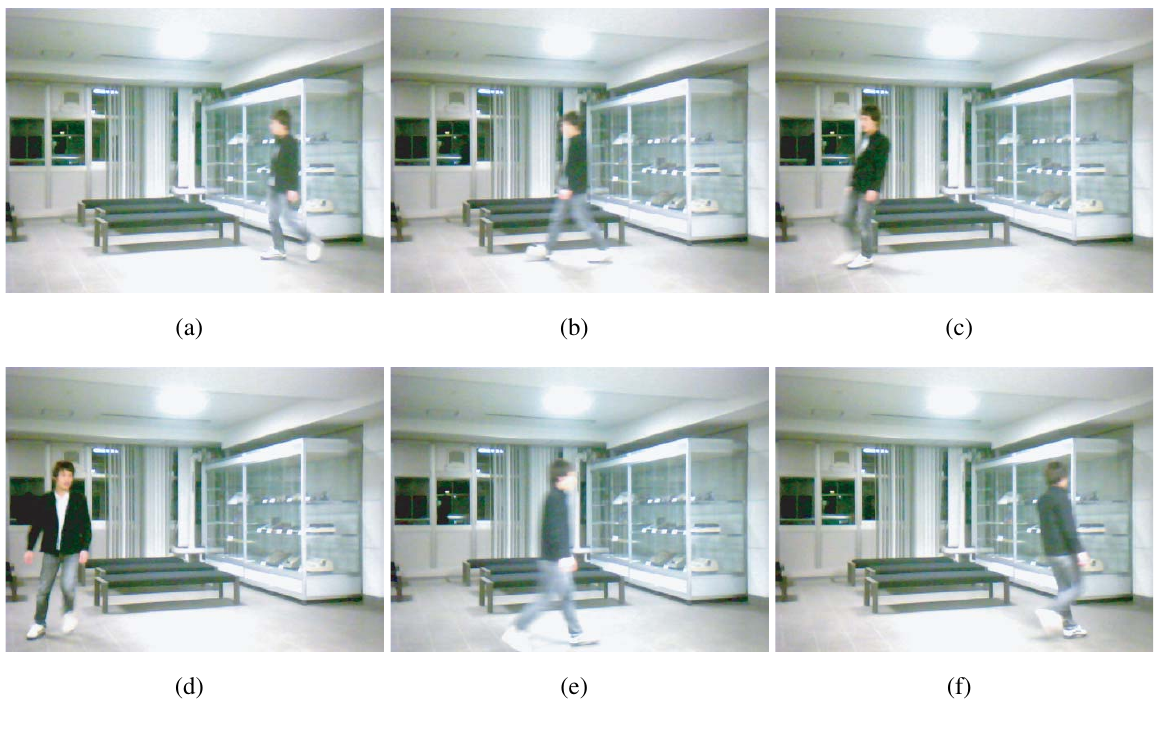
Figure 9. The real scene whose brightness sequence is used as the envelope of the input for simulation, which assumes a surveillance scenario, (a) 0 s, (b) 3.082 s, (c) 7.291